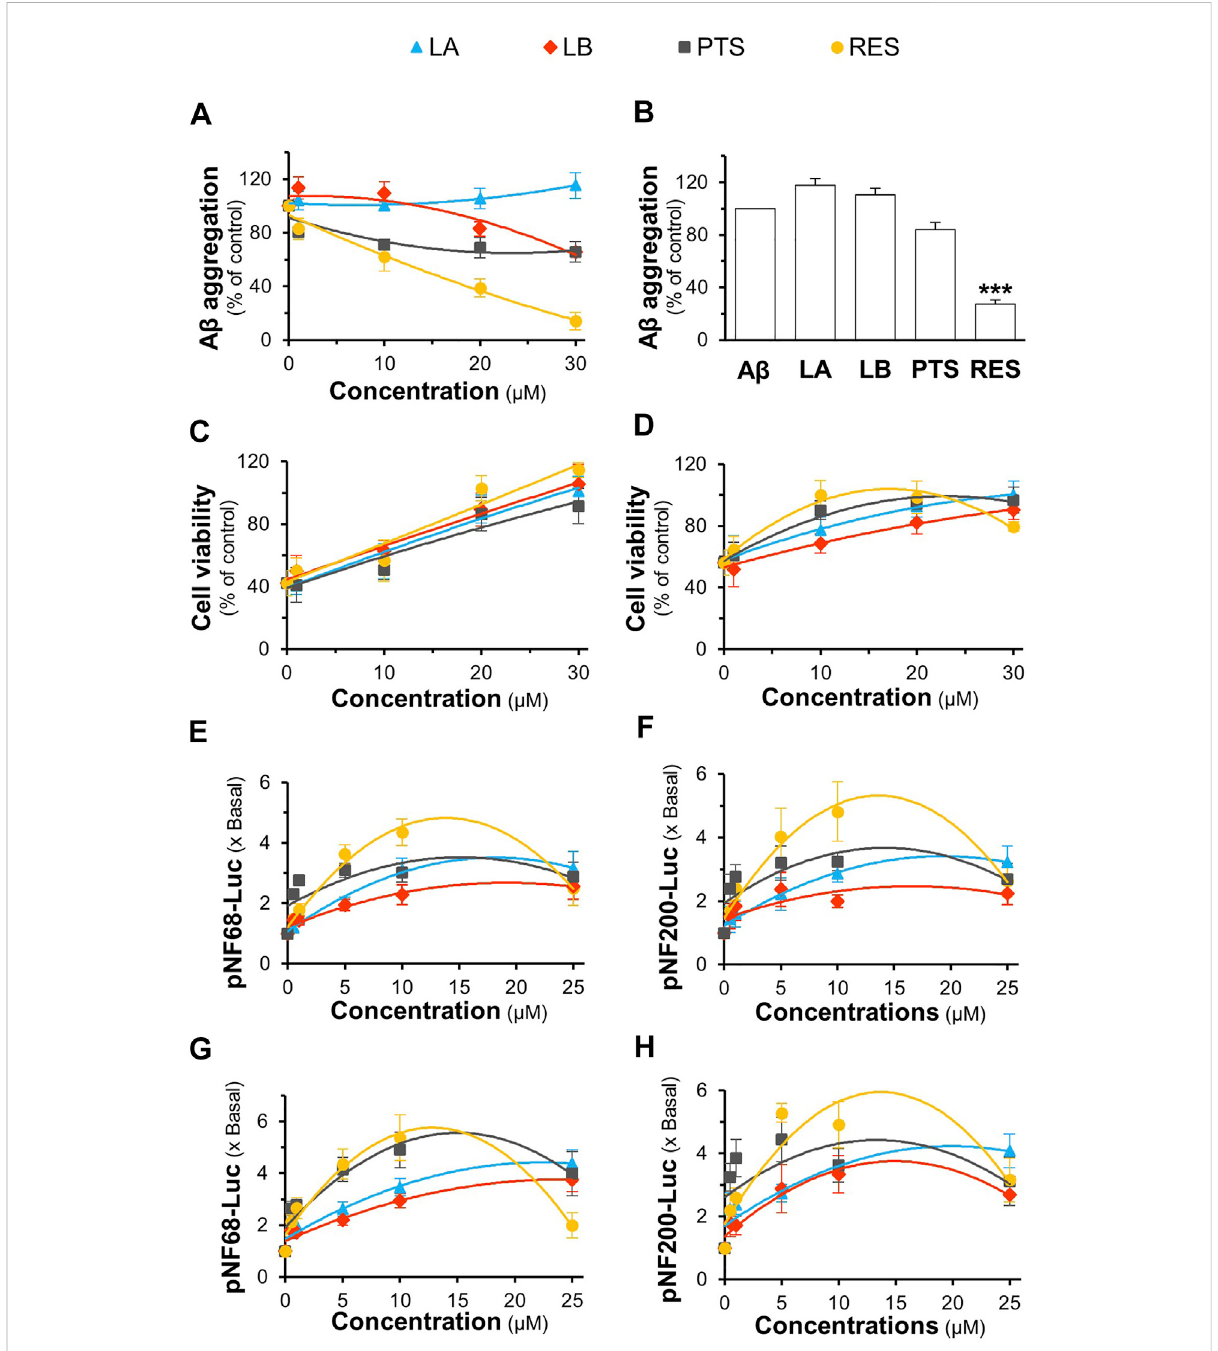
FIGURE 9 Role of D. cochinchinensis stemwood extract phytochemicals in inhibiting A β aggregation and promoting cell viability and differentiation in PC12 cells. (A) Blockage of A β 1-42 fi bril formation: A β 1-42 monomers (10 μ M) were aggregated or co-aggregated with the different concentrations (1 – 30 μ M) ofloureirin A (LA),loureirin B (LB), pterostilbene(PTS), or resveratrol (RES) at37 ° C for 6 days (B) Disruption of A β aggregation: The aged A β fi brils(10 μ Mat6-days)wereincubatedwithorwithoutthesefourcompounds(30 μ M)at37 ° Cfor5 days,thensubjectedtotheThT fl uorescent assay. (C) TheA β 1-42 monomersaggregates(10 μ M)withorwithoutthephytochemicalsat1 – 30 μ Mfor6 dayswereappliedtoPC12cellsfor24 h (D) PC12 cells were pre-treated with these phytochemicals for 24 h and exposed to A β 1-42 fi brils (10 μ M; aged for 6 days) for 24 h. The cell viability was determined bytheMTT assay. (E,F) pNF68-Luc orpNF200-Luc transfected PC12cellsweretreated withconcentrationsof0.5,1,5, 10,and 25 μ Mof thecompoundsfor24 h (G,H) ThepNF68-Luc-orpNF200-Luc-transfectedPC12cellswereco-treatedwithphytochemicalsand1.5 ng/mlNGFfor 24 h. Luciferase activity of pNF68-Luc and pNF200-Luc is represented as fold change (x Basal) to untreated cells. All values are in mean ± SEM for n =